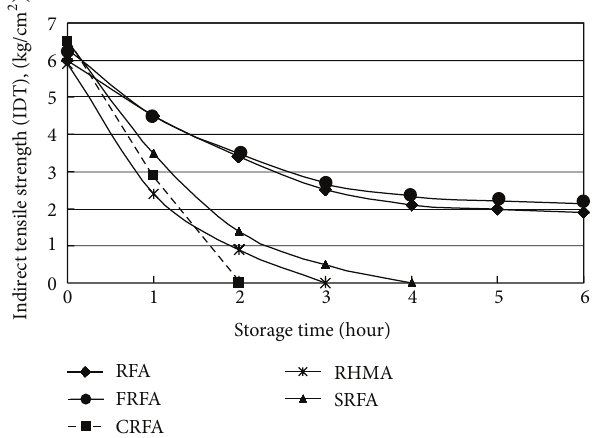
Figure 8: Effect of storage time on indirect tensile